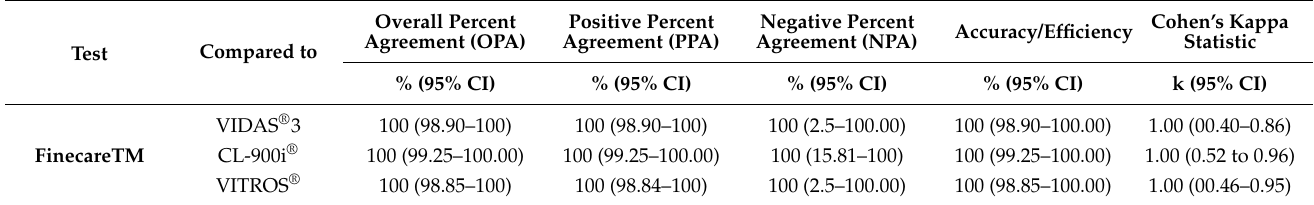
Table 2. Concordance assessment between FinecareTM and the three automated anti-SARS-CoV-2 immunoassays (CL-900i ® , VIDAS ® 3, and VITROS ® ).